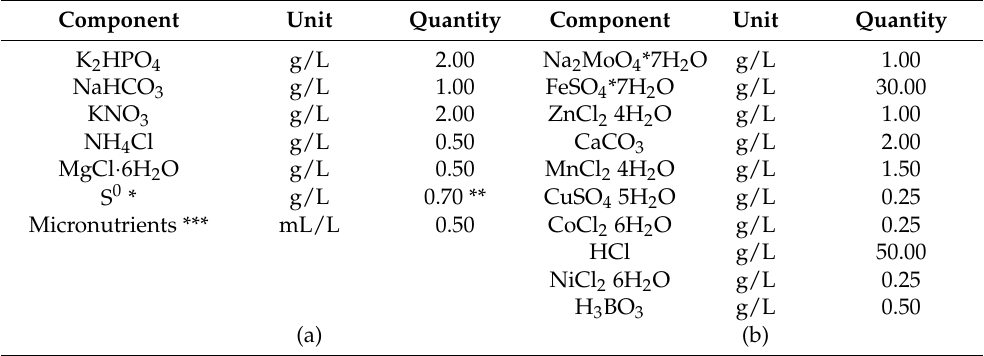
Table 1. (a) Composition of synthetic wastewater used in the autotrophic denitrification, (b) composi- tion of